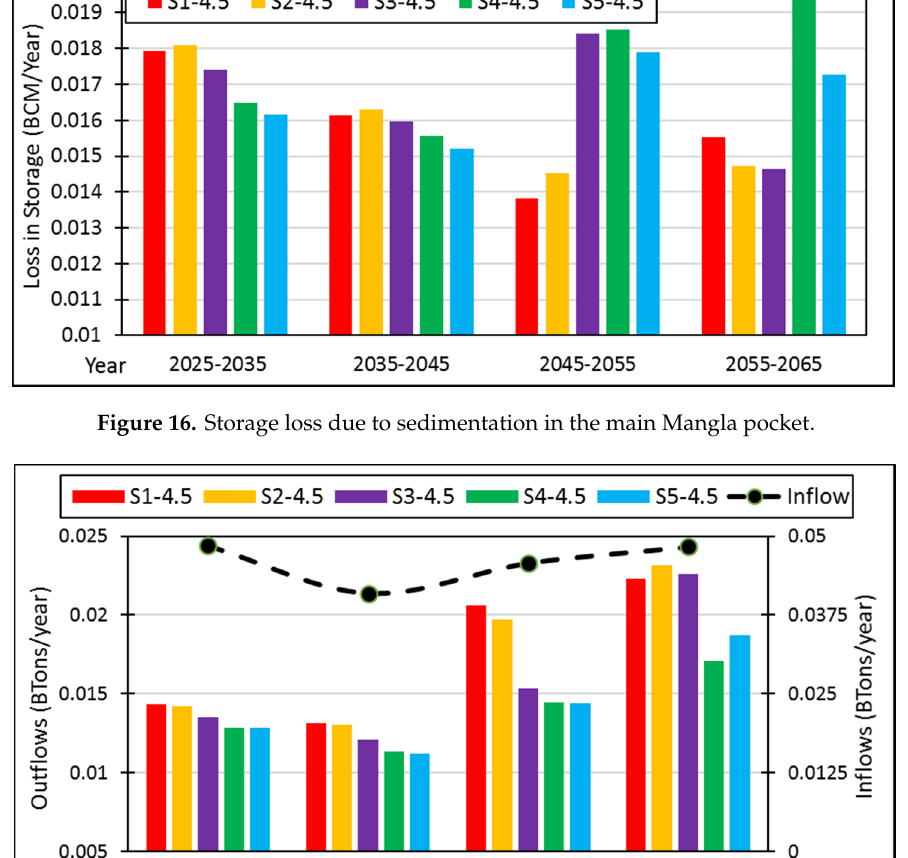
Table 7. Comparison of the sand outflow with respect to sand inflow in percentage.